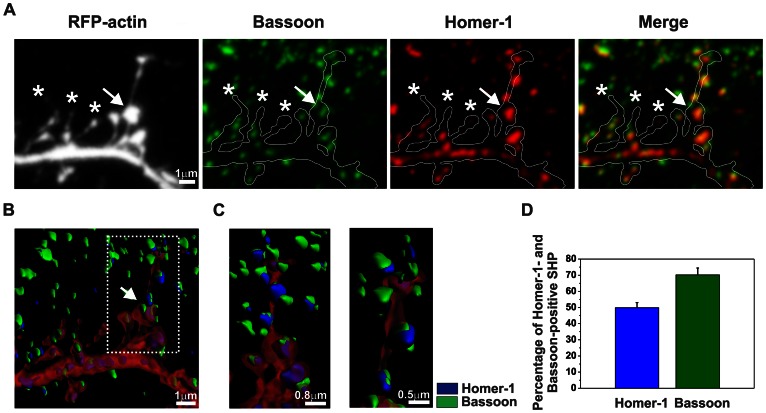
Spine head protrusions induced by cLTP form synapses.(A) A short segment of a neuronal dendrite labelled with anti-Bassoon and anti-Homer-1 antibodies is shown at 40 min of cLTP. Spine head protrusions with terminal swelling contained the postsynaptic marker Homer-1 and approached presynaptic Bassoon. The arrow indicates the location of a spine that turned into a SHP that exhibited terminal swelling. Short SHPs induced by cLTP did not exhibit terminal swelling and did not contain synaptic markers. Stars mark the location of spines that carried protrusions with a lack of synaptic markers. (B-C) Three-dimensional reconstruction of a short stretch of dendrite with spines and processes that emerged from the spine head after immunolabelling of presynaptic Bassoon (green) and postsynaptic Homer-1 (blue). (B) The arrow marks the formation of a SHP that exhibited terminal swelling. (C) High-magnification photographs depict SHP that contained postsynaptic Homer-1 and terminated at presynaptic Bassoon. (D) Column bars indicate mean (± SEM) percentages of Homer-1- or Bassoon-positive SHPs after 40 min cLTP.